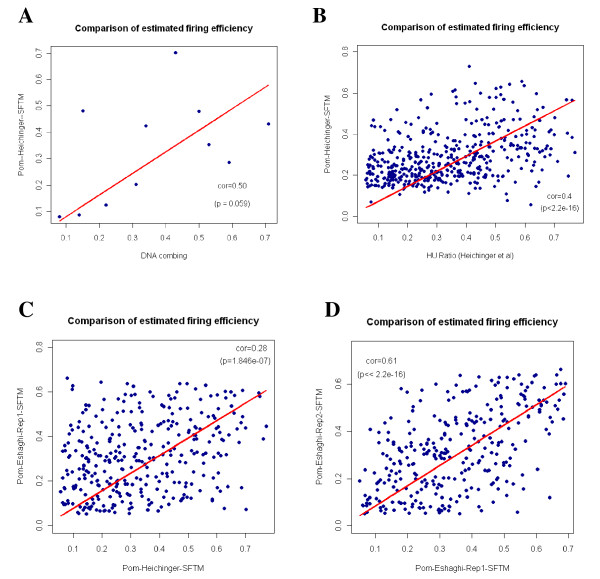
Comparison of estimated firing efficiencies of origins in S.pombe. (A) Comparison of estimated S.pombe origin efficiencies from single DNA molecular technique (Patel et al, 2006) and the proposed SFTM model applied to the Pom-Heichinger microarray data. The efficiencies of 11 origins estimated by both methods are plotted against each other. (B) Comparison of estimated origin efficiencies by measuring the signal ratio in the HU experiment (Heichinger et al, 2006) and the proposed SFTM model applied to the Pom-Heichinger time-course microarray data. (C) Comparison of estimated origin efficiencies by applying the proposed SFTM model to two microarray datasets: Pom-Heichinger and Pom-Eshaghi. (D) Comparison of estimated origin efficiencies by applying the proposed SFTM model to the two repeats of DNA replication dataset Pom-Eshaghi. The red line in these figures shows a linear fitting (without intercept) of the two estimations illustrated in each figure. The good consistency between these results indicates that SFTM is a reliable and valid method to estimate firing efficiency at genomic scale.